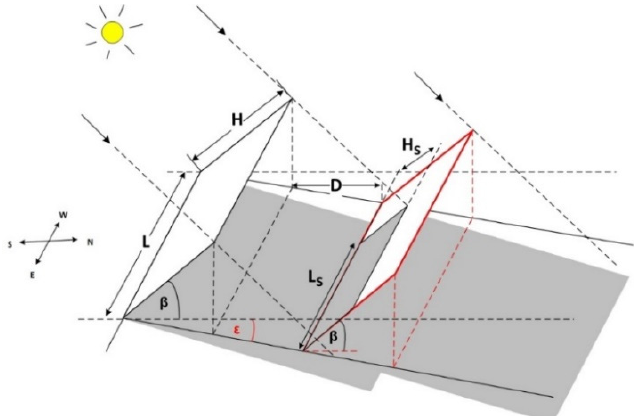
ε . Figure 7. Shadow on a collector deployed on a north-facing sloped plane ε